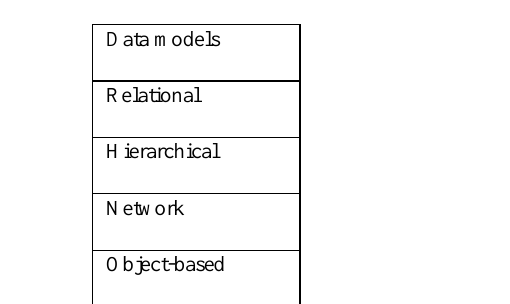
Table 7. Classification of database software according to data models.